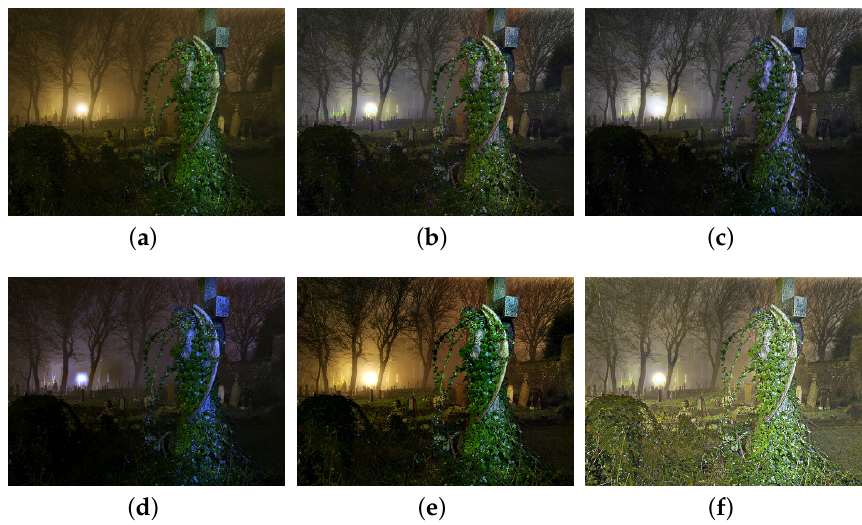
Figure 15. Comparisons with other nighttime dehazing methods on test image Tomb . ( a ): the nighttime hazy image, ( b ): MRP [11] result, ( c ): HDF [41] result, ( d ): GMLC [13] result, ( e ): PAB [9] result, ( f ): SIDE